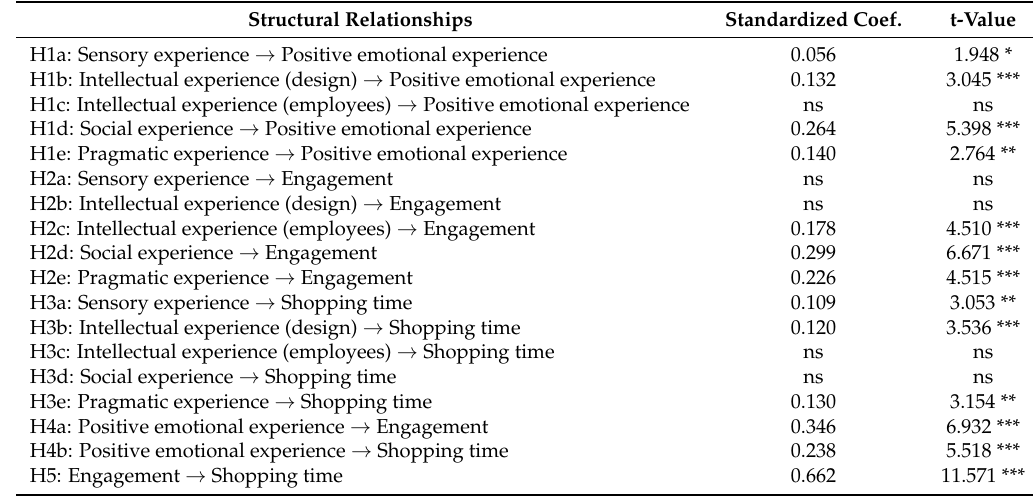
Table 5. Results of the structural equation model analyses.